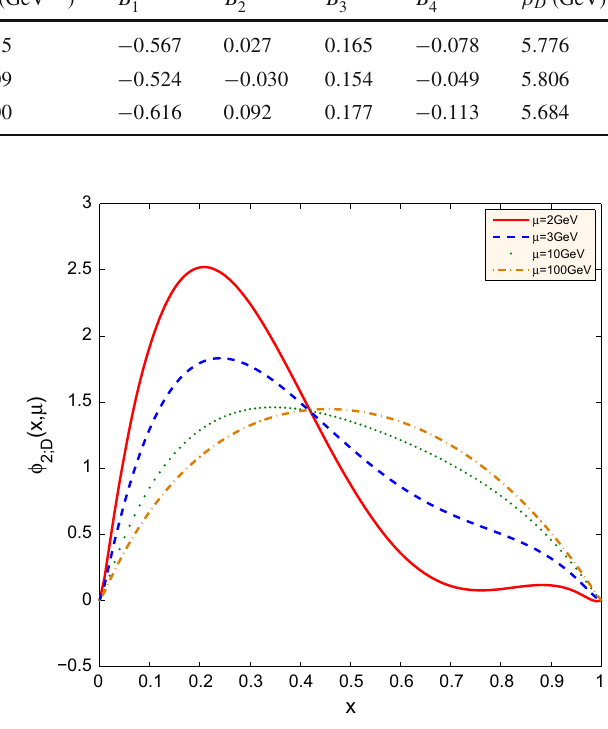
Fig. 4 The curves of the D -meson leading-twist DA φ 2 ; D with the parameter values exhibited in Table 4